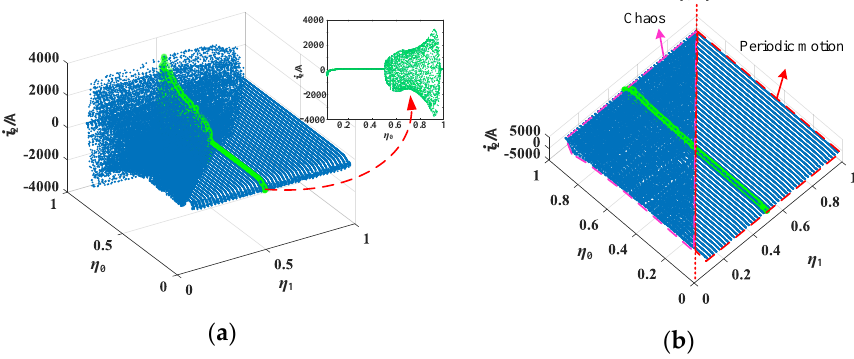
Figure 10. ( a ) Three-dimensional bifurcation diagram and ( b ) its top view with both η 0 and η 1 being bifurcation parameters.